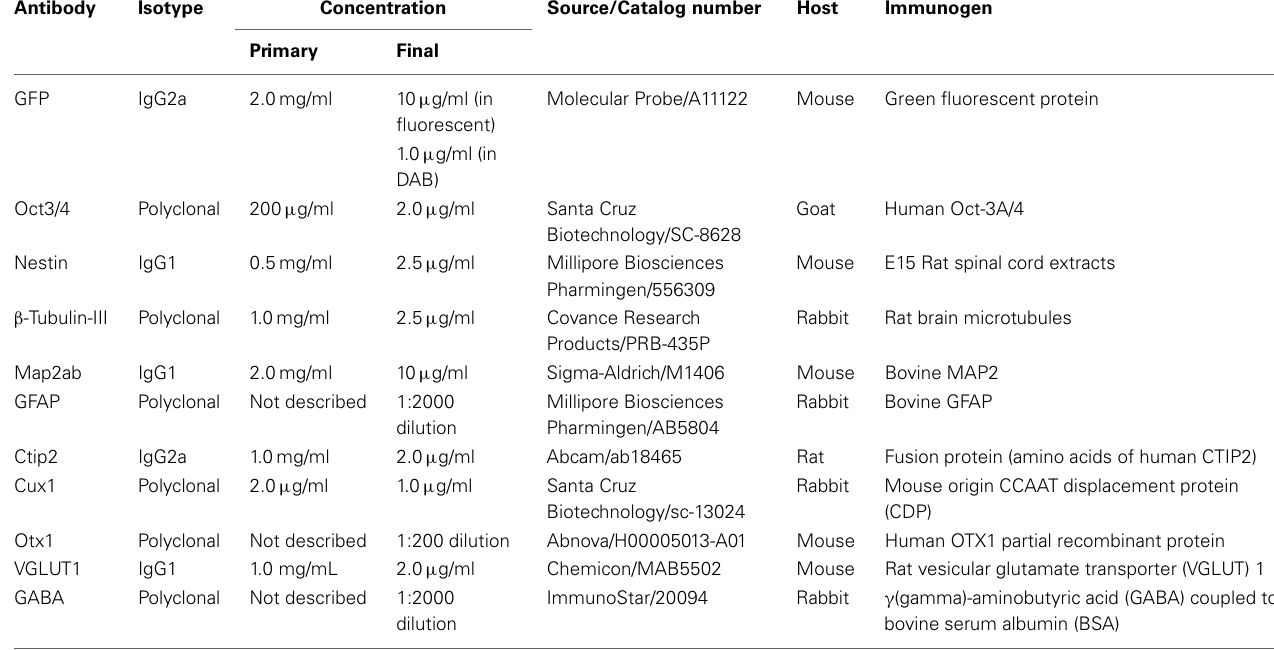
Table 1 | Antibodies information used in this study. Antibody